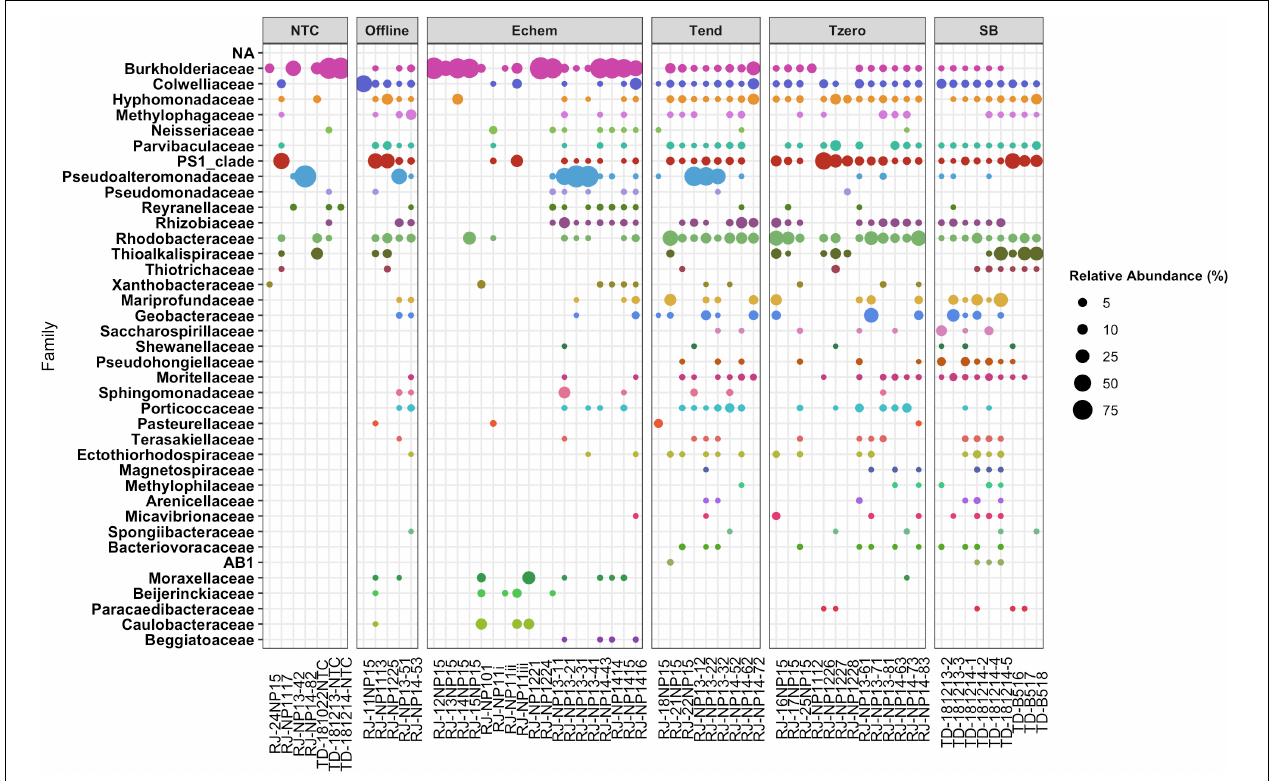
FIGURE 7 | Relative abundance of Proteobacteria taxonomic families as a subset of data shown in Figure 6